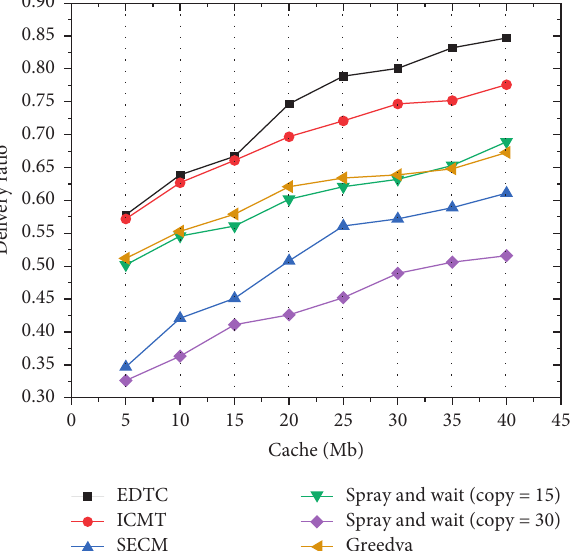
Figure 15: Relationship between end-to-end delay on average and